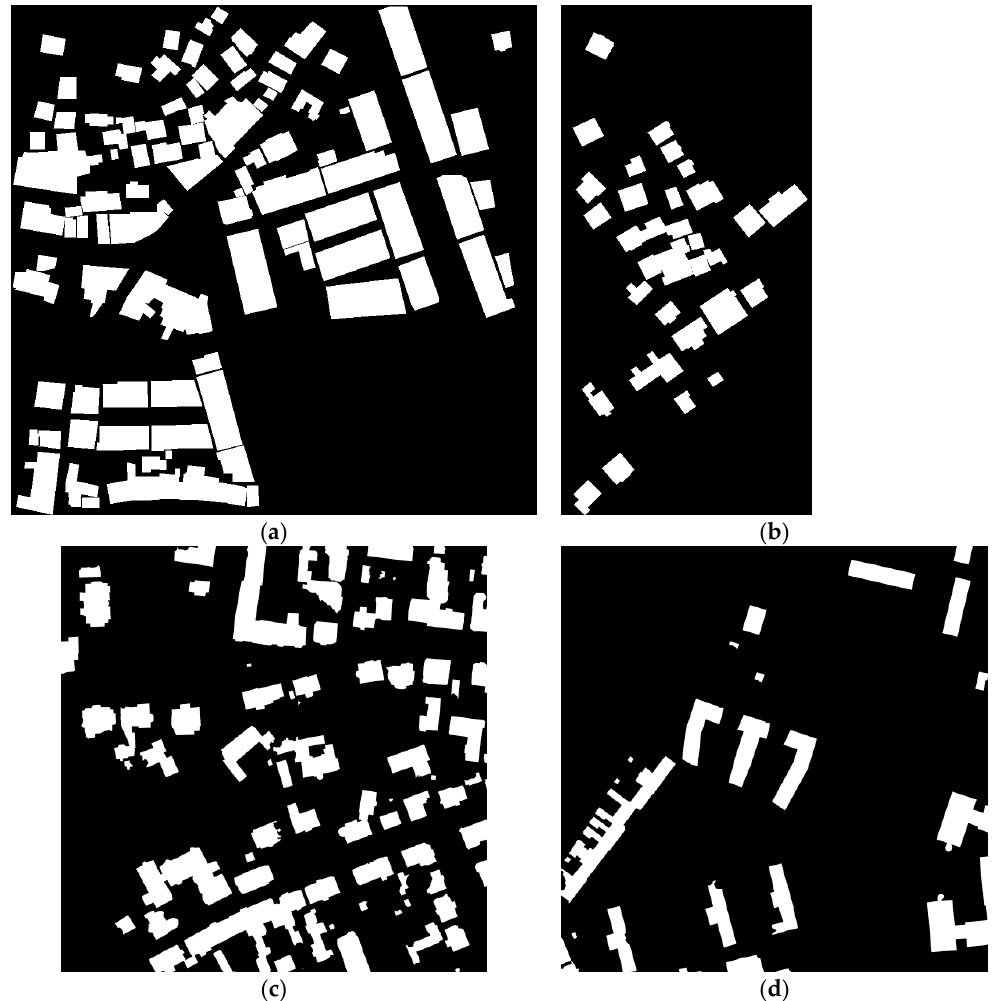
Figure 12. Ground-truth buildings of the four datasets. ( a ) and ( b ) are the ground-truth buildings of two UAV datasets. ( c ) and ( d ) are the ground-truth buildings collected from the ISPRS dataset. White and black denote building and non-building regions, respectively.